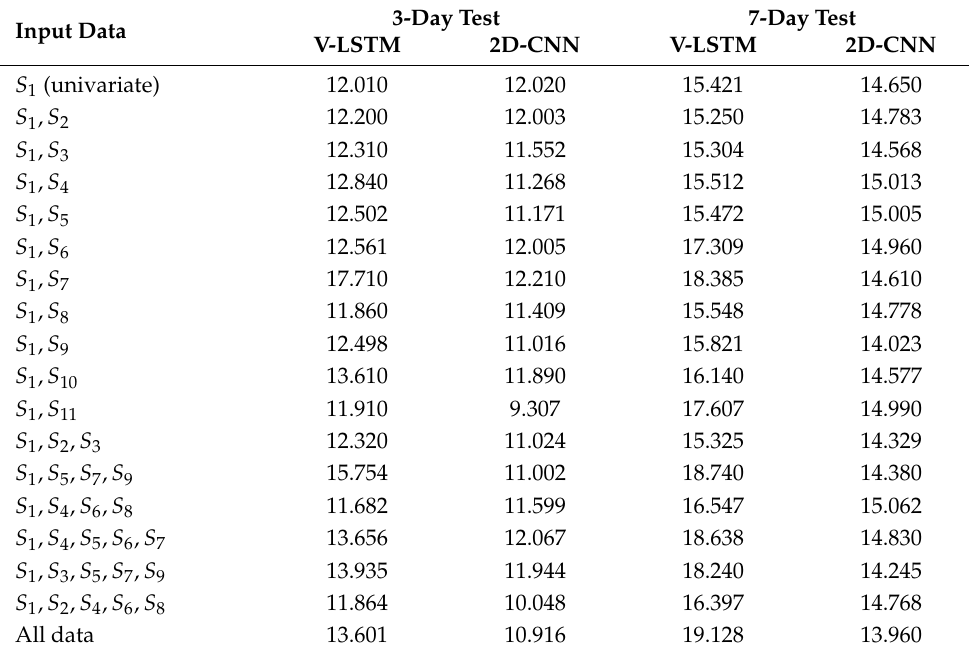
Table 6. Average RMSE for July 2018 tests, carried out by using V-LSTM and 2D-CNN models and different combinations of time